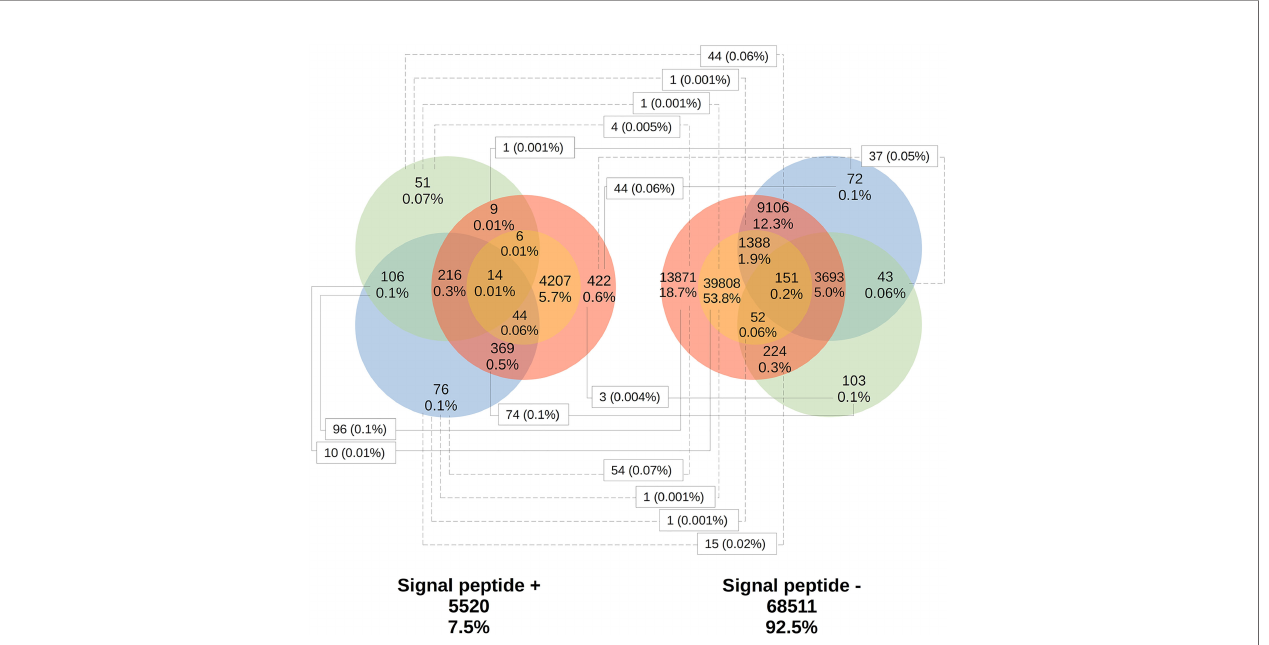
FIGURE 3 | Total distribution of ORFs predicted by the existence of signal peptide. Using TransDecoder, Augustus, and ORF fi nder, the total ORFs for the transcripts is 74,031. 27,910 (37.9%) with ORF fi nder (Matched ORF), in red; 45,670 (61.7%) with ORF fi nder (Unmatched ORF), in yellow; 15,278 (20.7%) with TransDecoder, in blue, and 4,668 (6.3%) with Augustus, in green. Only 7.5% of the ORFs have the presence of signal peptide (SP+) against 92.5% with SP-. *:_ Corresponding ORFs from the same transcript, but with different amino acid sequences and SP